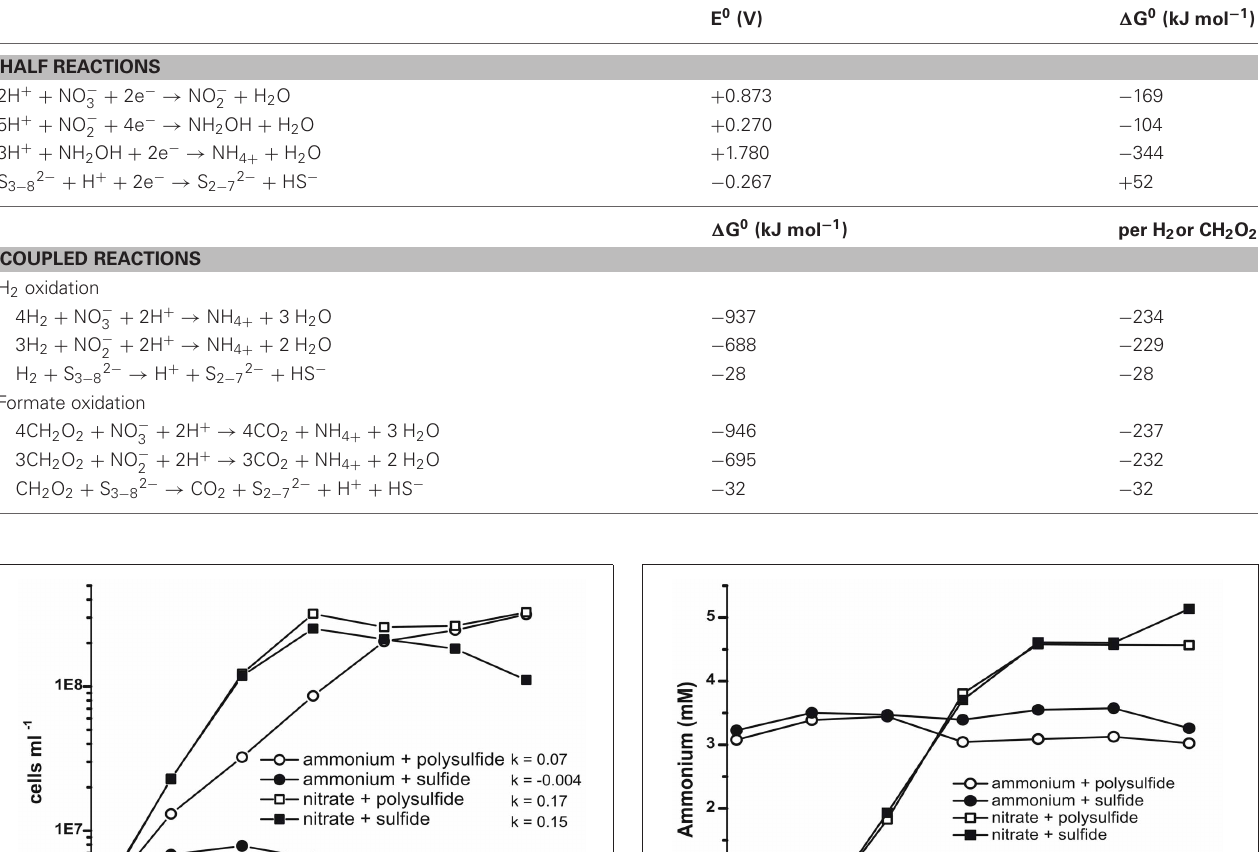
Table 2 | Calculated free energies of reaction under standard conditions (1M all species, 25 ◦ C and pH = 7) for electron accepting half reactions of nitrogen compounds and polysulfide and coupled reactions with formate or hydrogen as the electron donor.